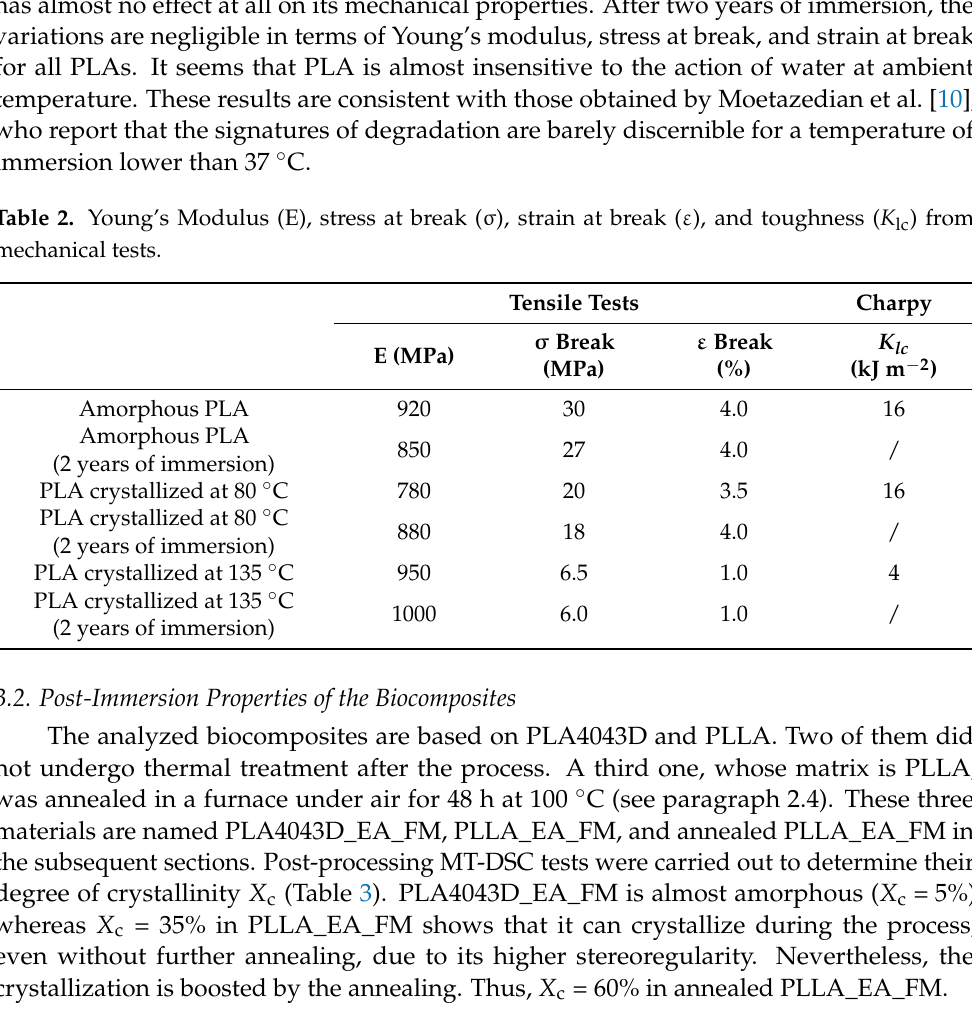
Table 3. Thermal properties of the